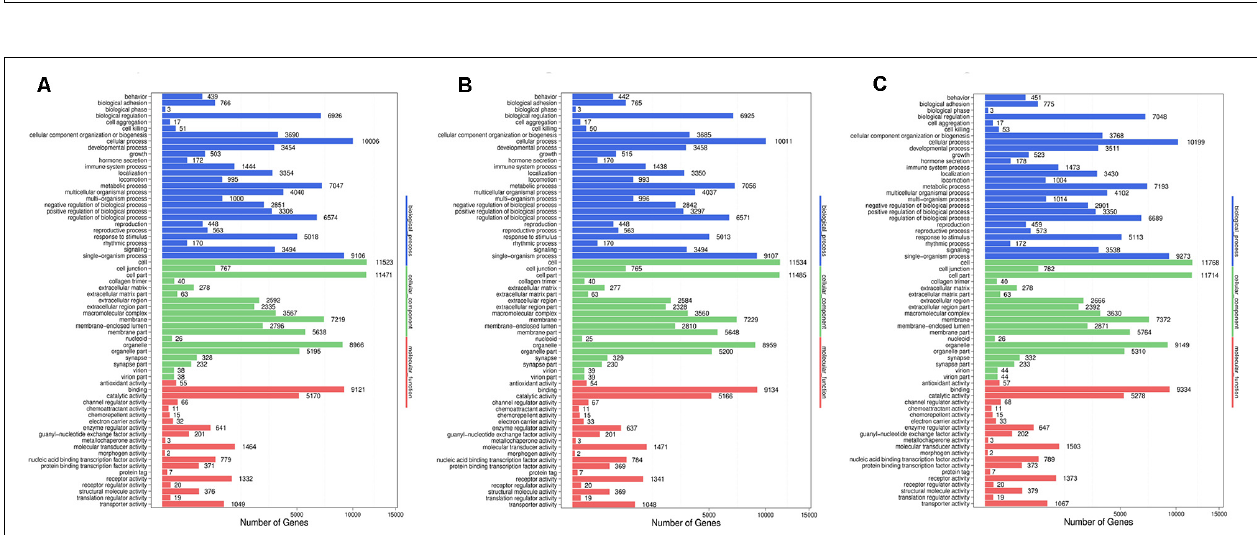
FIGURE 7 | Go functional classification of DES target genes from three comparison. (A) Comparison between negative control and positive control. (B) Comparison between negative control and P-ONE. (C) Comparison between negative control and P-TWO. X -axis means number of DEGs (the number is presented by its square root value). Y -axis represents GO terms. All GO terms are grouped in to three ontologies: blue is for biological processes; brown is for cellular component and orange is for molecular functions. According to three plots, DES target genes may enrich in similar pattern under three therapeutic conditions, implying that such three therapeutic methods (HR4 antagonist, P-ONE and P-TWO) may have similar pharmacological mechanisms and microRNA may play an irreplaceable role during such processes.